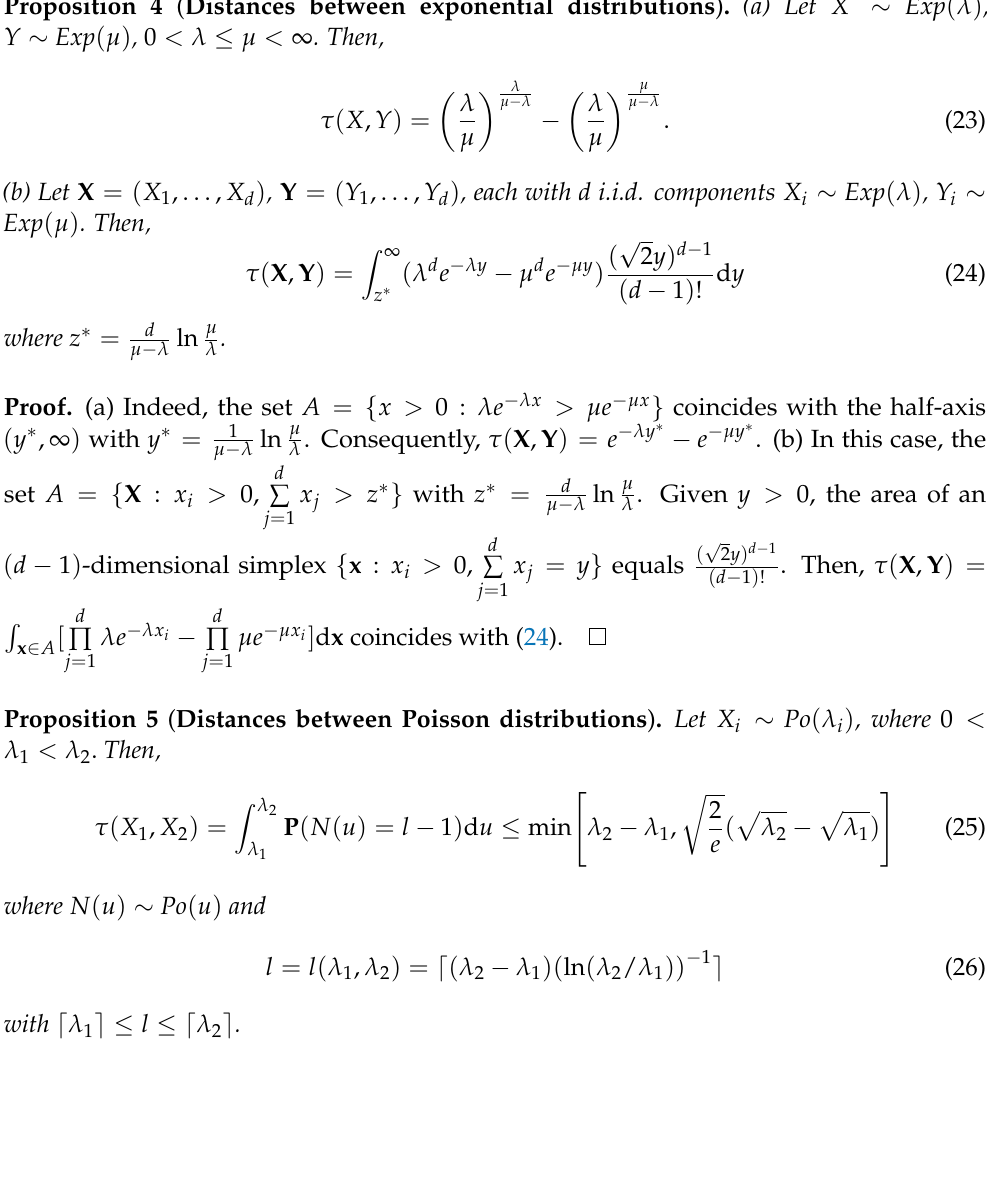
) , Bin ( 20, 1 + a )) and ( b ) 2 2 ≤ 2 and the orange curve for λ 1 ≥ λ 1